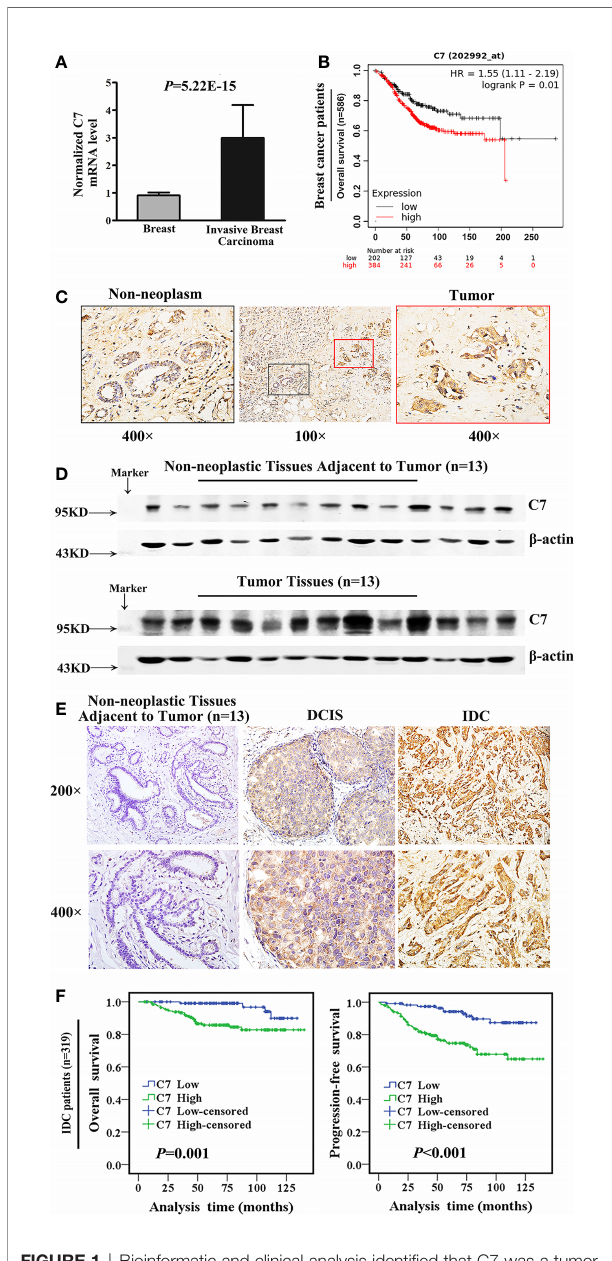
FIGURE 1 | Bioinformatic and clinical analysis identi fi ed that C7 was a tumor promoter in breast cancer. (A) Normalized C7 mRNA levels were analyzed based on the gene expression pro fi ling data from the ONCOMINE database, including 53 invasive breast carcinoma cases and 6 normal breast samples. (B) OS curves of breast cancer patients with C7 mRNA expression in the Kaplan-Meier plotter database. (C) C7 expression was shown in non- neoplastic and neoplastic segments. Red rectangle represented tumors and black rectangle represented non-neoplastic tissues adjacent to tumor (magni fi cation 100× and 400×). (D) Western blot analysis of C7 expression in breast tumor specimens (IDC, n = 13) and their corresponding non-neoplastic breast tissues adjacent to tumor (n = 13). b -actin was used as a loading control. (E) Immunohistochemical staining of C7 in clinical specimens of non- neoplastic breast tissues adjacent to tumor, ductal carcinoma in situ (DCIS), and invasive ductal carcinoma (IDC). (F) Overall survival (OS) and progression- free survival (PFS) curves of IDC patients (n = 319) (log-rank